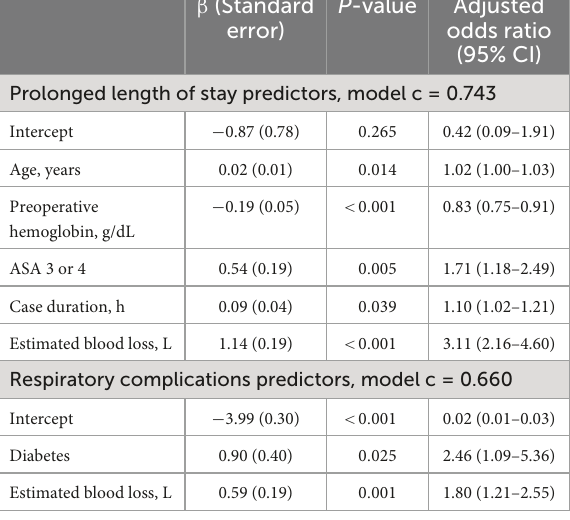
TABLE 3 Multivariable analysis summary statistics for prolonged length of stay and respiratory